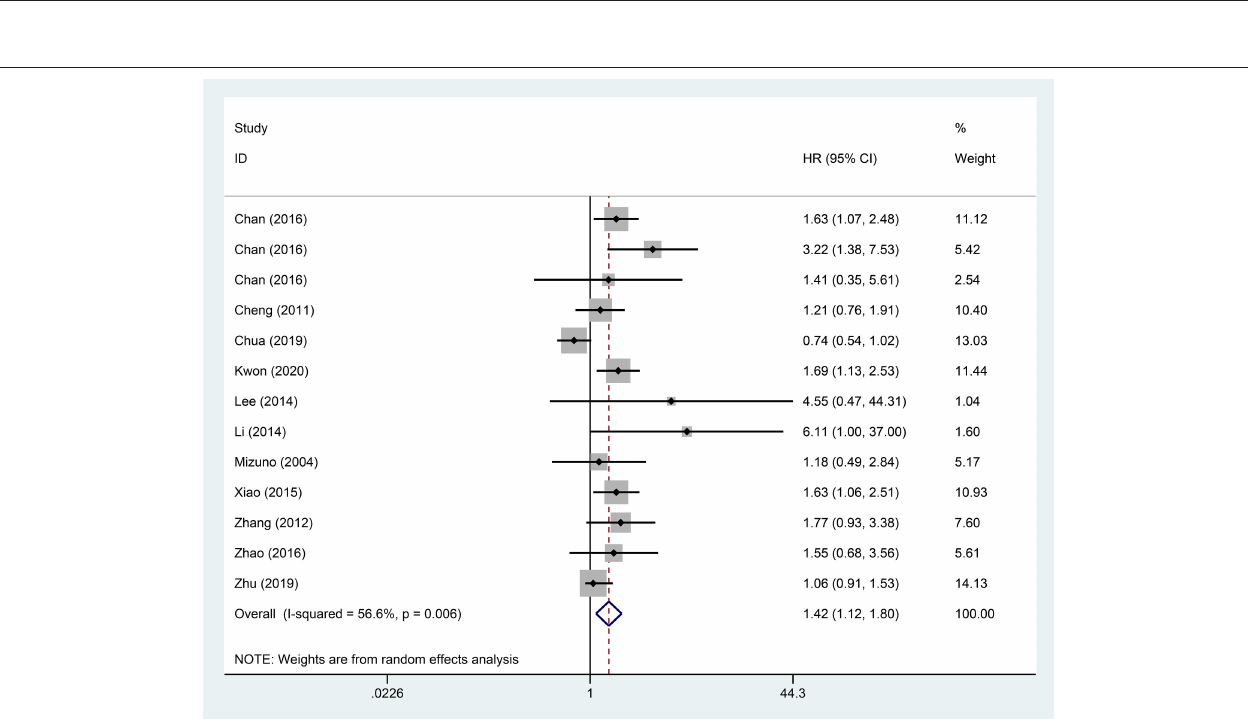
FIGURE 3 | Forest plot of DFS of ruptured hepatocellular carcinoma (HCC) patients following hepatectomy ( P = 0.004).